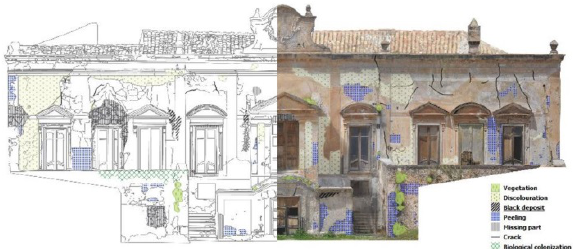
Figure 15. South-east façade ortho-image.